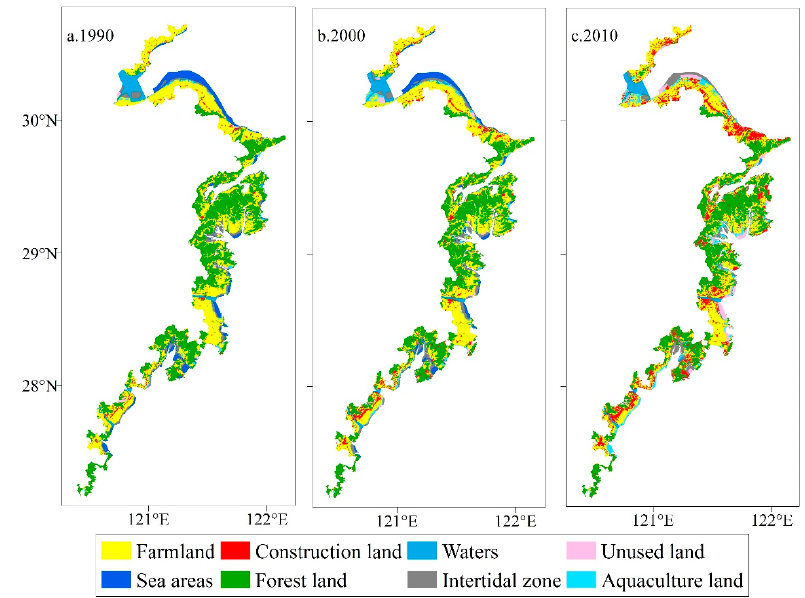
Figure 2. Land-use maps of the coastal zones in Zhejiang Province in the years 1990, 2000, and 2010. ( a ) the map of land-use type in the year 1990; ( b ) the map of land-use type in the year 2000; ( c ) the map of land-use type in the year 2010. Table 3. The changes of land use in the coastal zones in Zhejiang Province from 1990 to 2010.